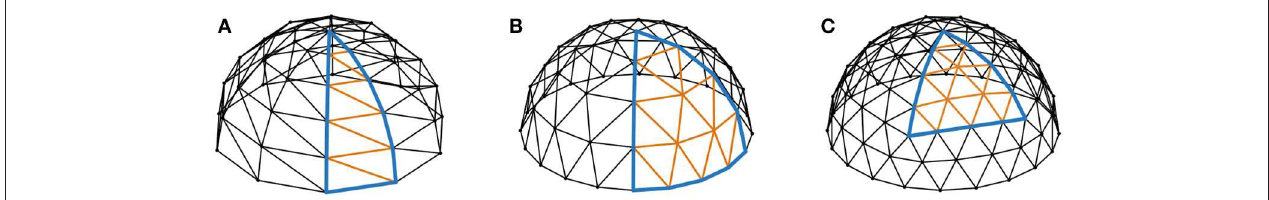
FIGURE 1 | Three commonly built dome types are compared in this paper: (A) the Schwedler dome, (B) the Kiewitt dome, (C) the geodesic dome. Each type is described parametrically as a repetition of one subdivided module, which is highlighted in the